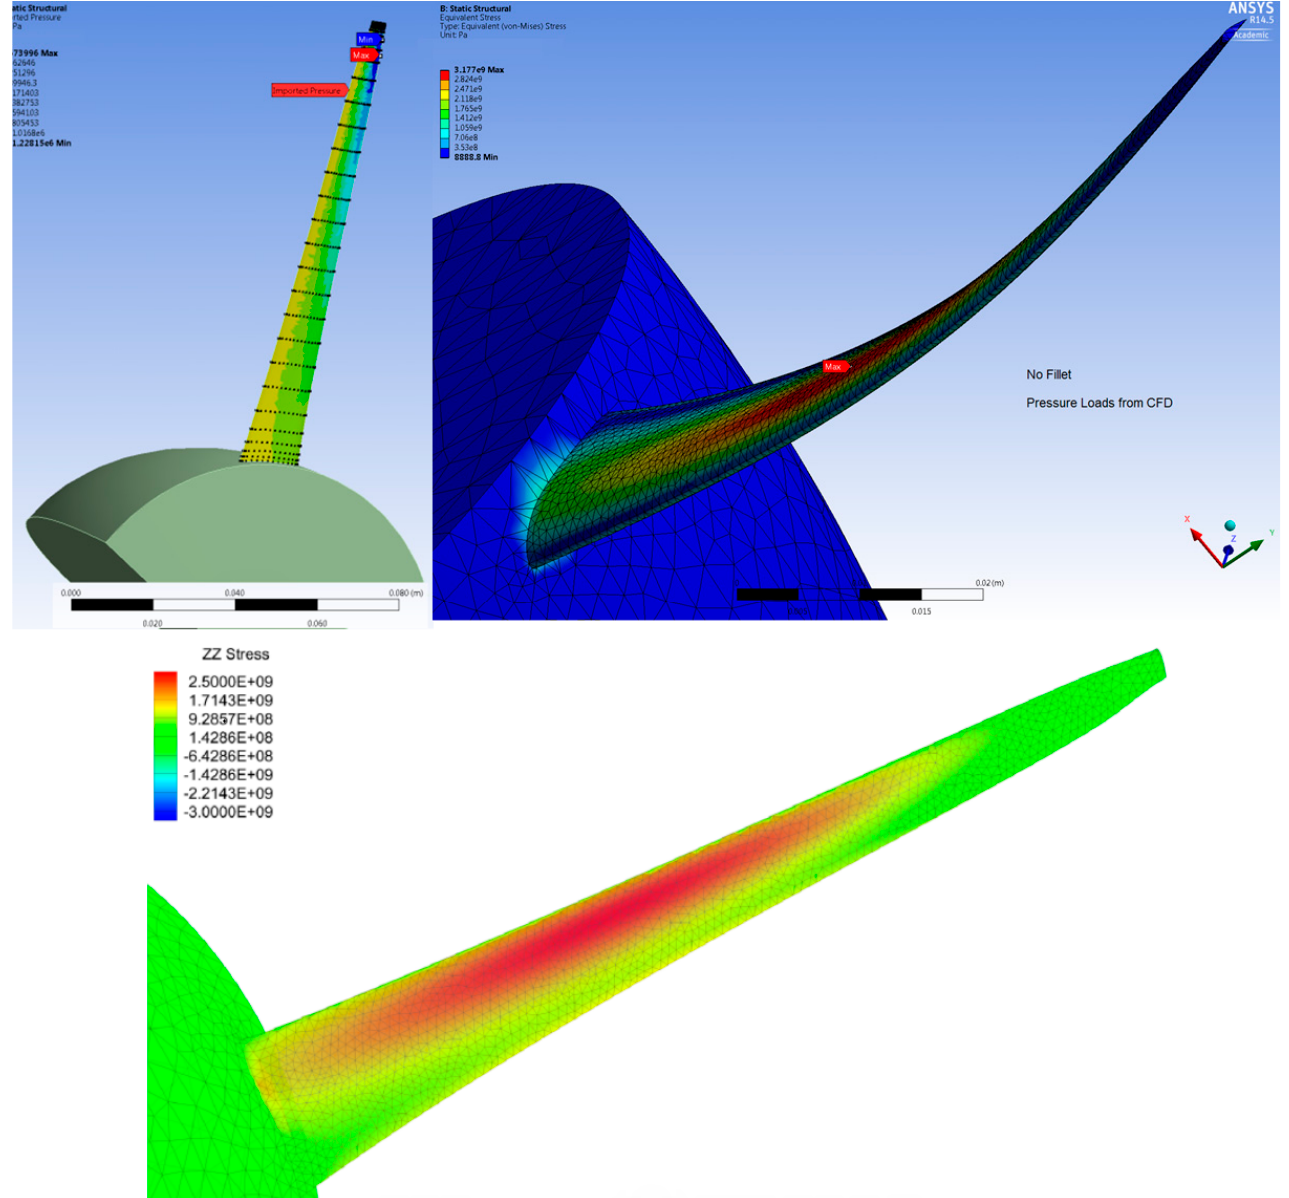
Figure 36. One-way FSI of 4 kW HKT with pressure loads mapped from 3D CFD.